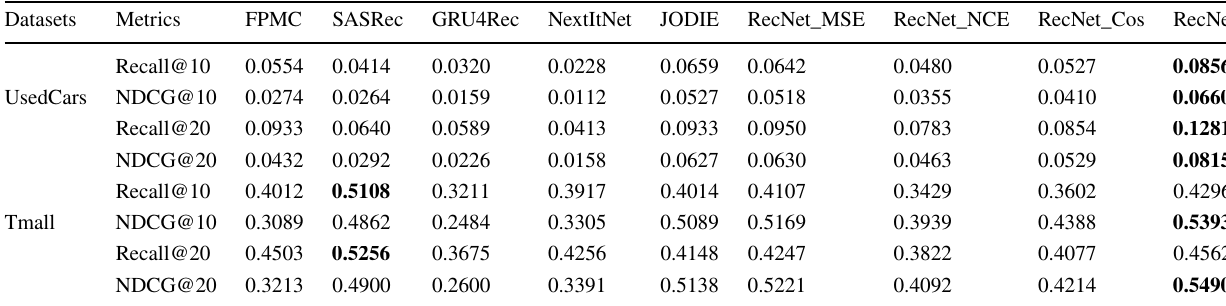
Best results are shown in